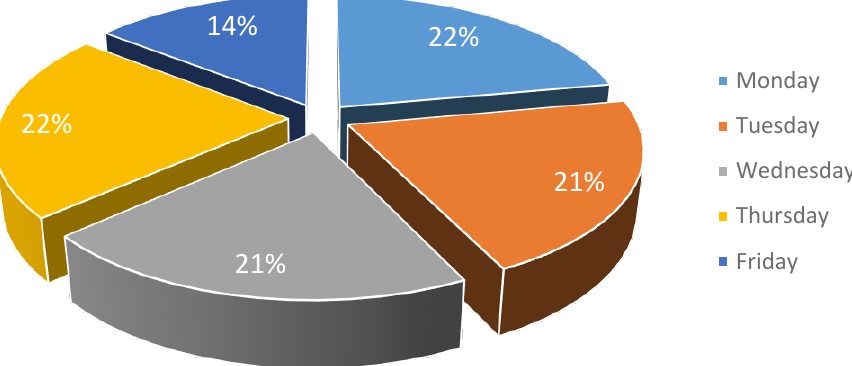
Figure 1. Day of the week and gaps in the Ukrainian stock